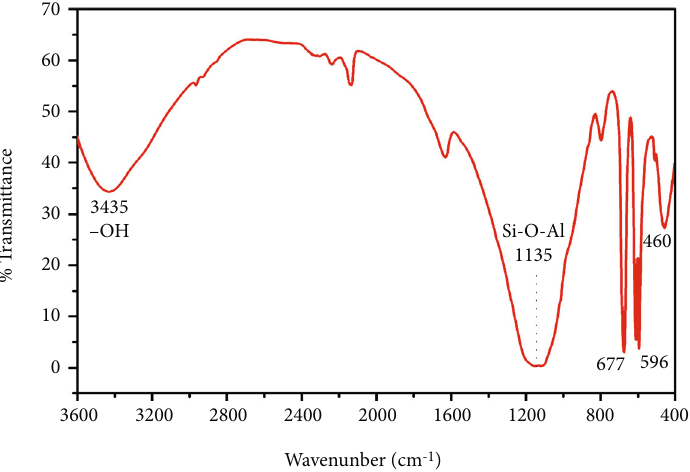
Figure 2: FTIR spectra of calcium-rich zeolite particles.